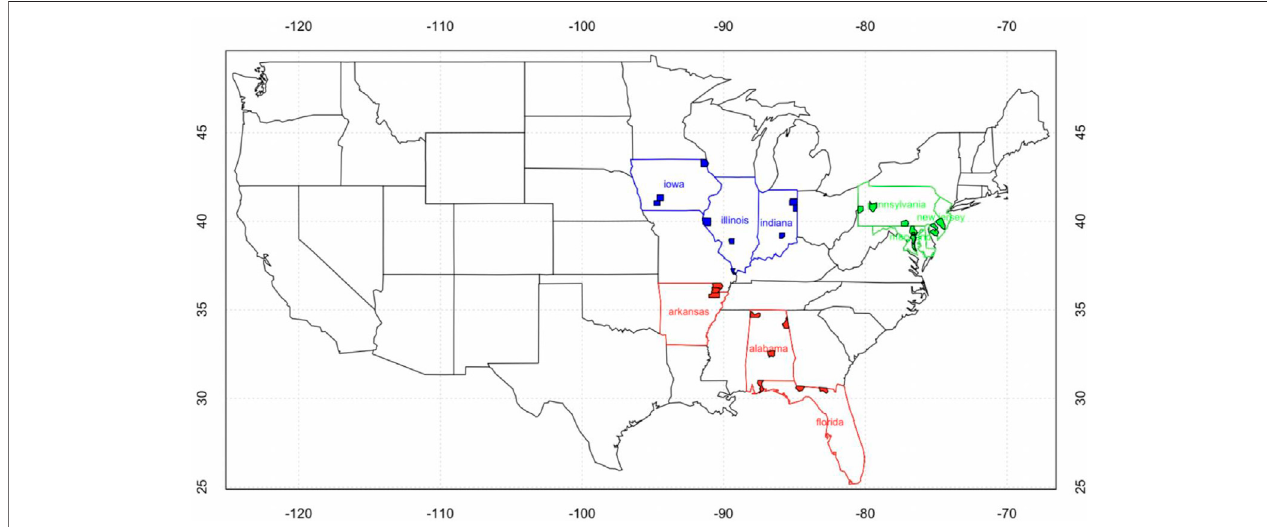
FIGURE 1 | The selected states and counties for Group 1, Group 2 and Group 3.